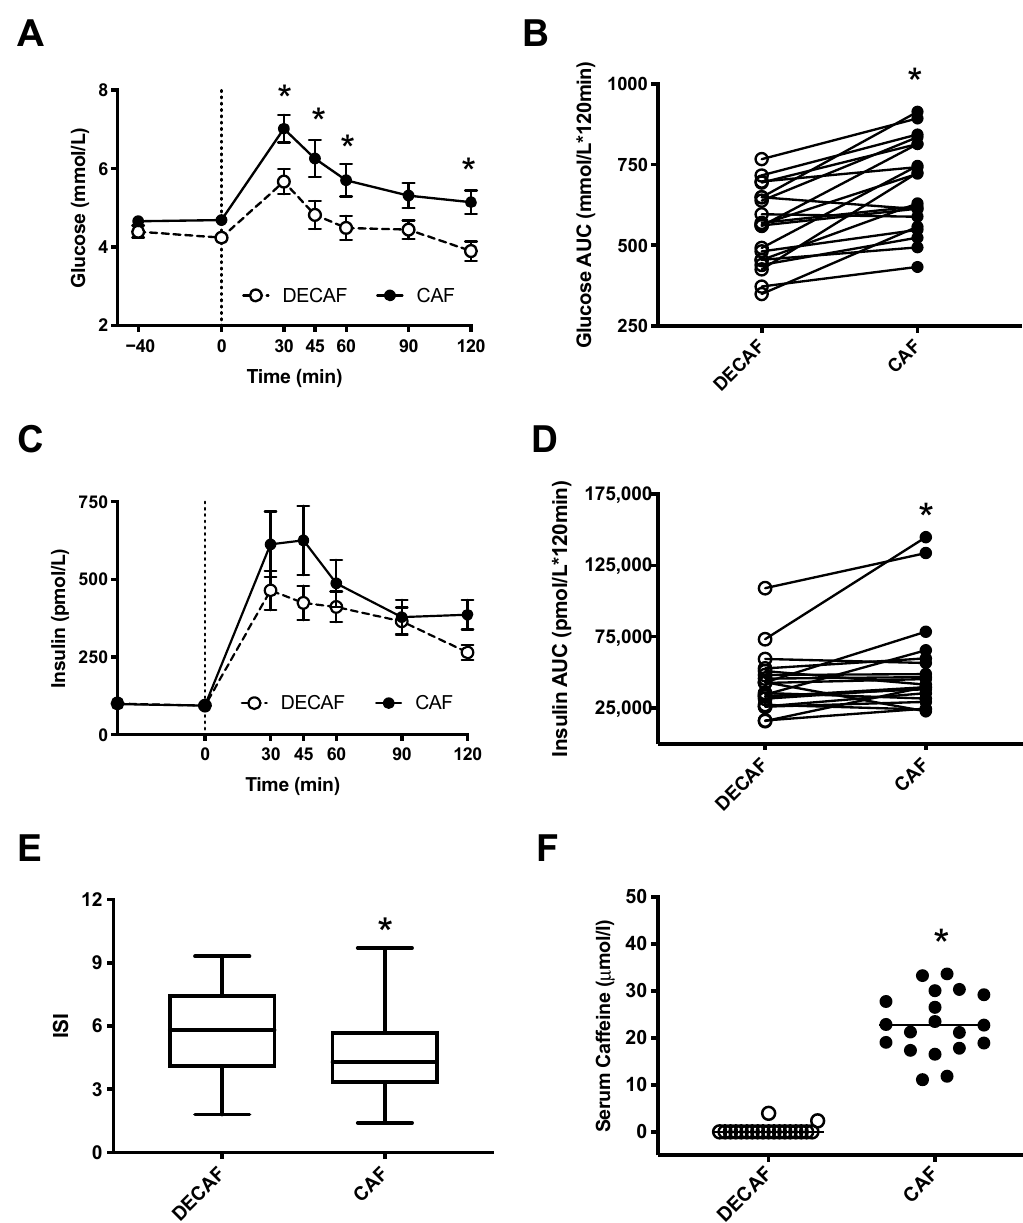
Figure 1. Postprandial glucose and insulin responses following ingestion of either a decaffeinated (DECAF) or caffeine-containing (CAF, 5 mg/kg) energy shot at − 40 min followed by an oral glucose tolerance test (OGTT) at 0 min (indicated by a dashed line). ( A ) Blood glucose excursion curves. ( B ) Individual changes in glucose area under the curve calculated by the trapezoidal method (AUC). ( C ) Insulin excursion curve. ( D ) Individual changes in insulin AUC. ( E ) Calculated Matsuda insulin sensitivity index (ISI) [22] for each treatment (95% confidence interval). ( F ) Mean serum caffeine concentrations obtained at 120 min of each OGTT. All data are shown as means ± SE, n = 20 subjects in a randomized, cross-over design. * Indicates p < 0.05, a statistically significant difference between treatments.